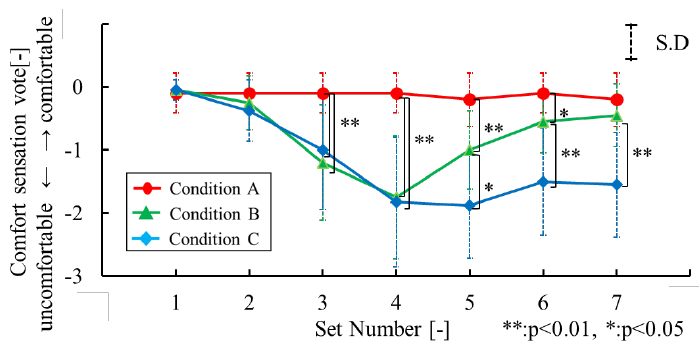
Figure 4. Results of the value of the thermal comfort sensation vote.